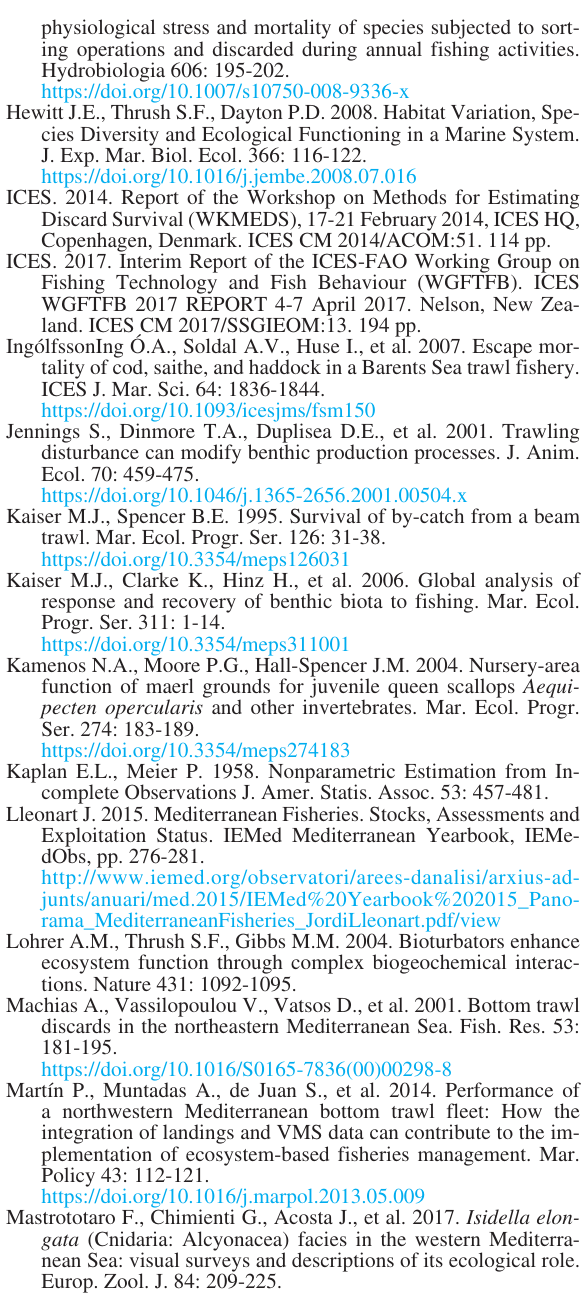
Table S1. – Information recorded during each haul in the two study